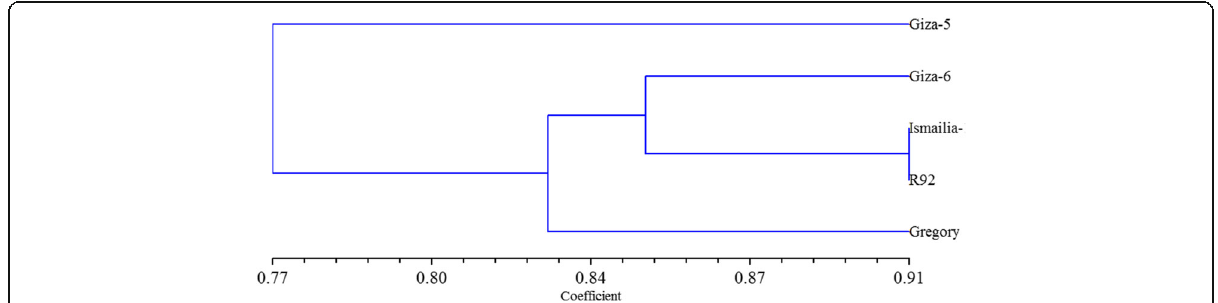
Fig. 2 Dendrogramtree of genetic distances among five peanut cultivars based on RAPD